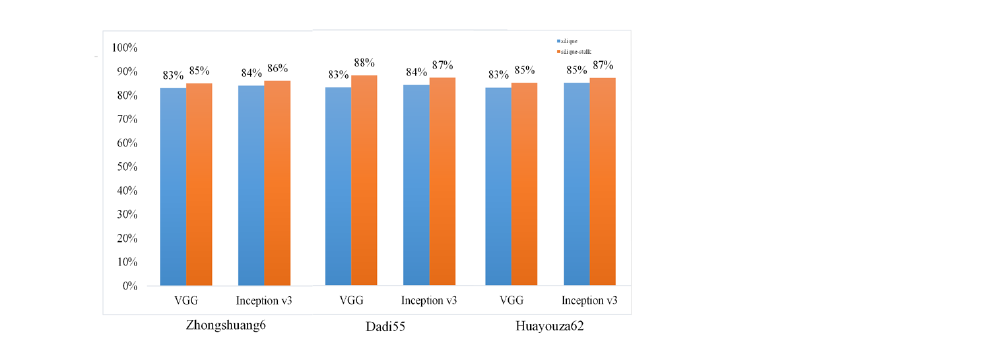
Figure 7. Comparison of canopy characteristics and silique-stalk characteristics in the 5-level classifi- cation with the Inception v3-LSTM.